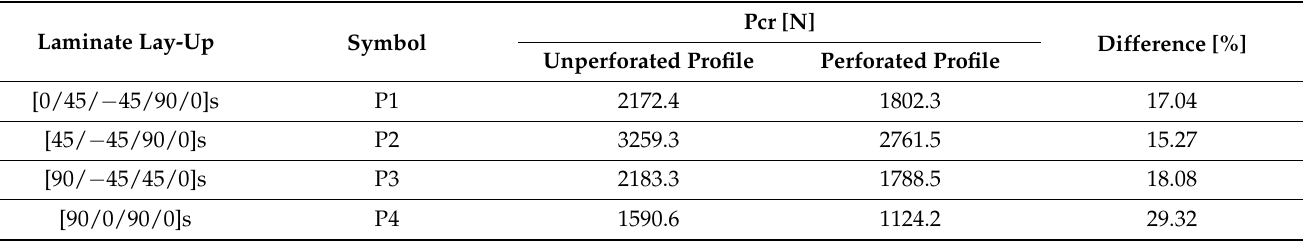
Table 4. Values of critical load for perforated and unperforated profiles, for four different composite lay-ups for chosen